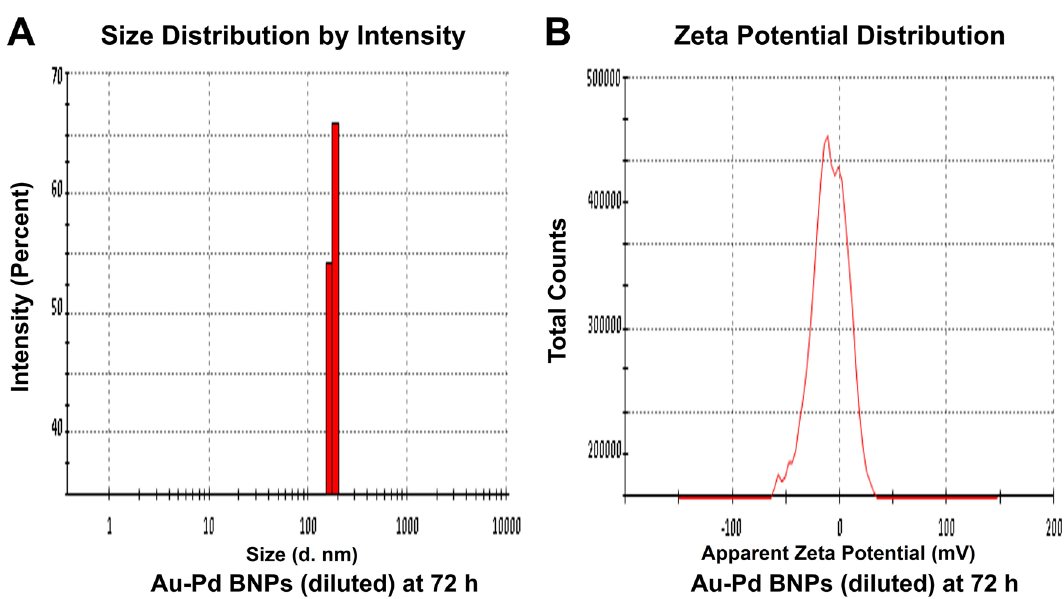
Figure 8. ( A ) DLS analysis and ( B ) Zeta Potential analysis, of the diluted (1:10) sample of 2 mM synthesized Au–Pd BNPs using 10% aqueous leaf extract of the plant Citrus limon at 72 h of